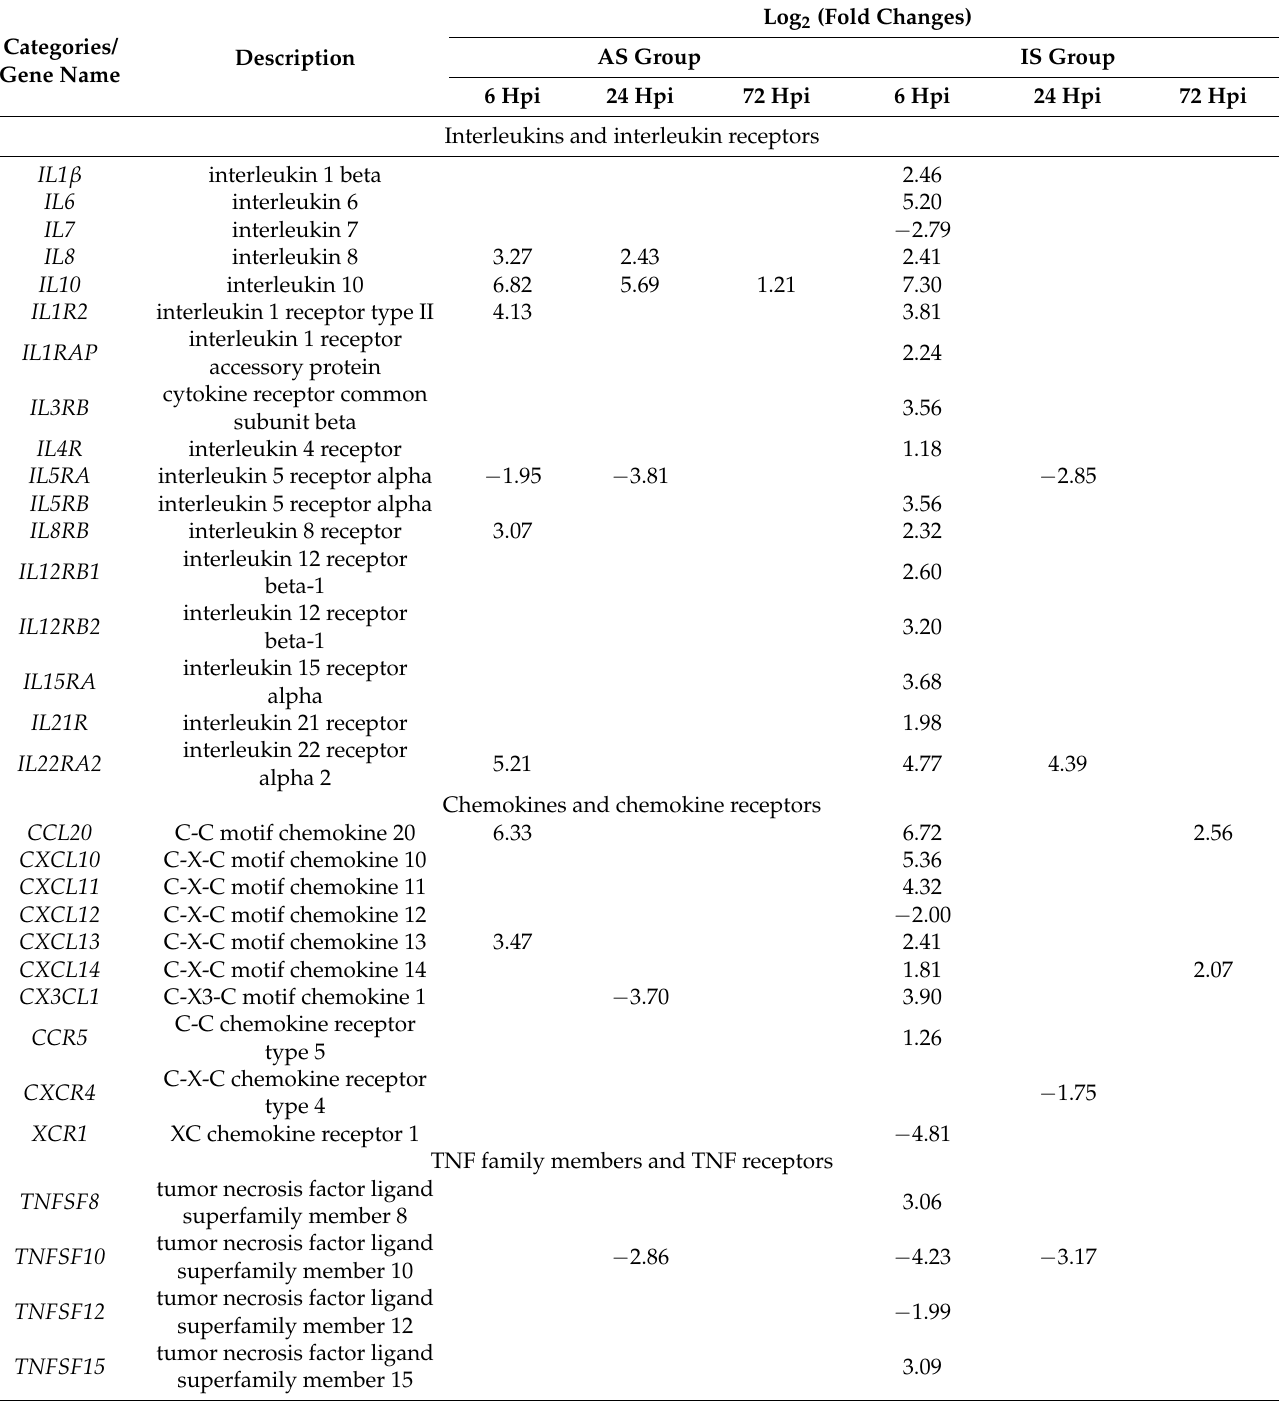
Table 4. Fold changes of differentially expressed cytokine and cytokine receptor, and cytokine expression mediating pathway genes in the AS group and the IS group compared to the